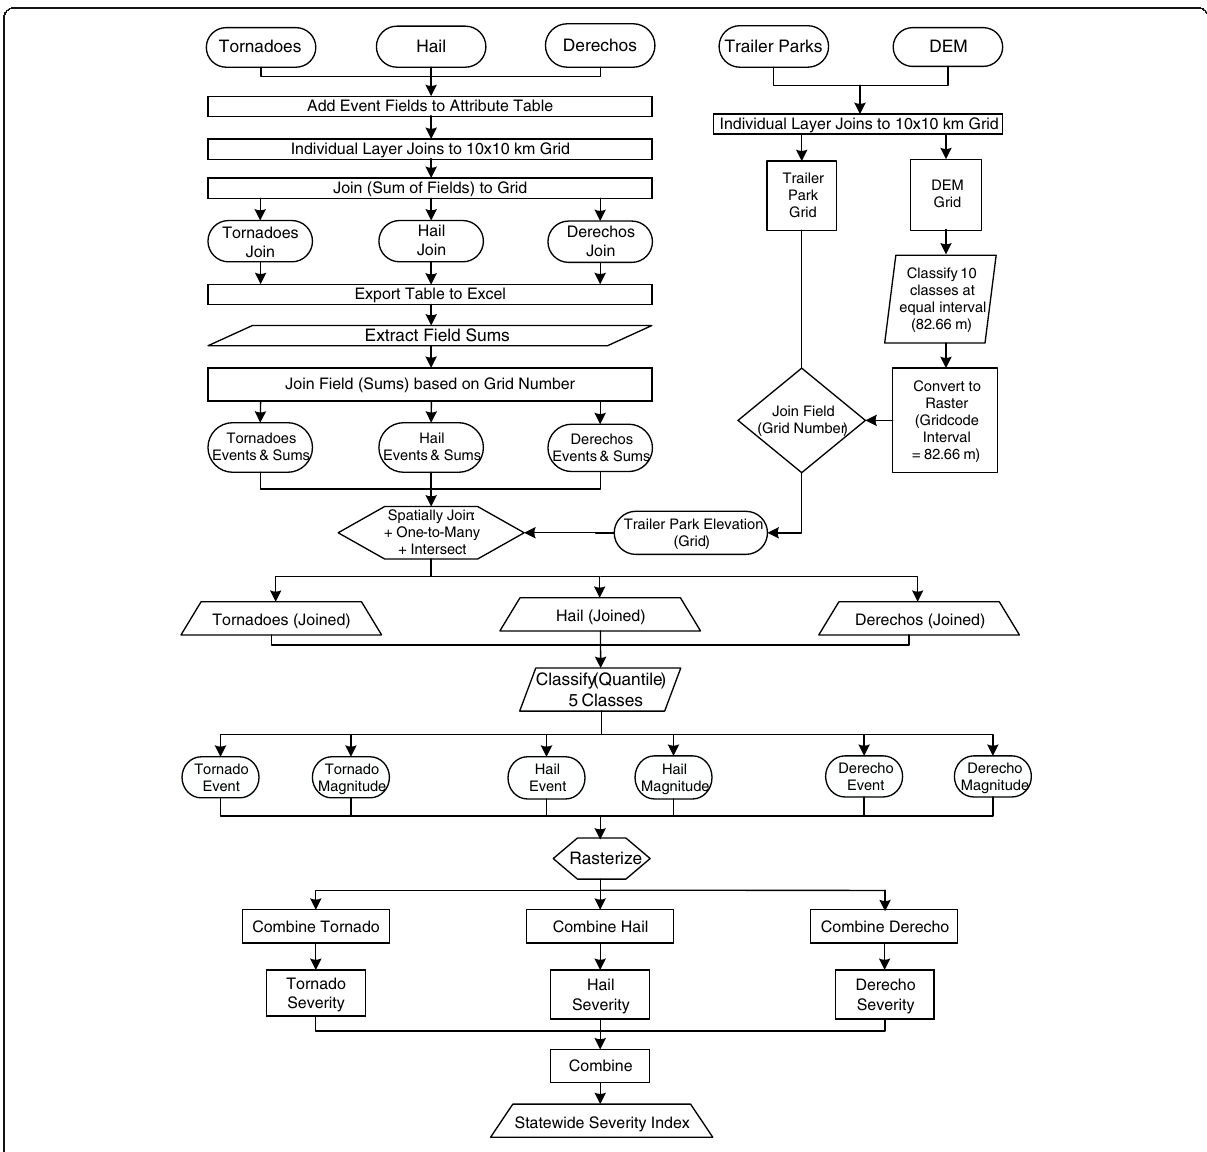
Fig. 5 Workflow for grid standardization and creating a statewide severity